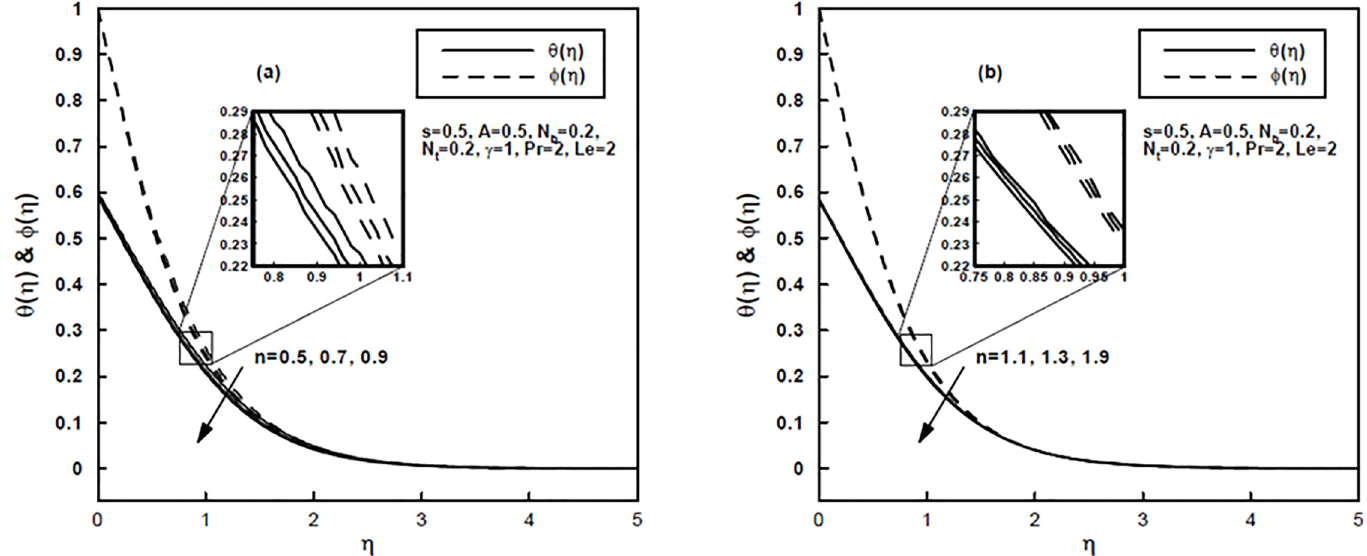
Fig 2. (a,b), The temperature and concentration profiles for different values of the power-law index n .